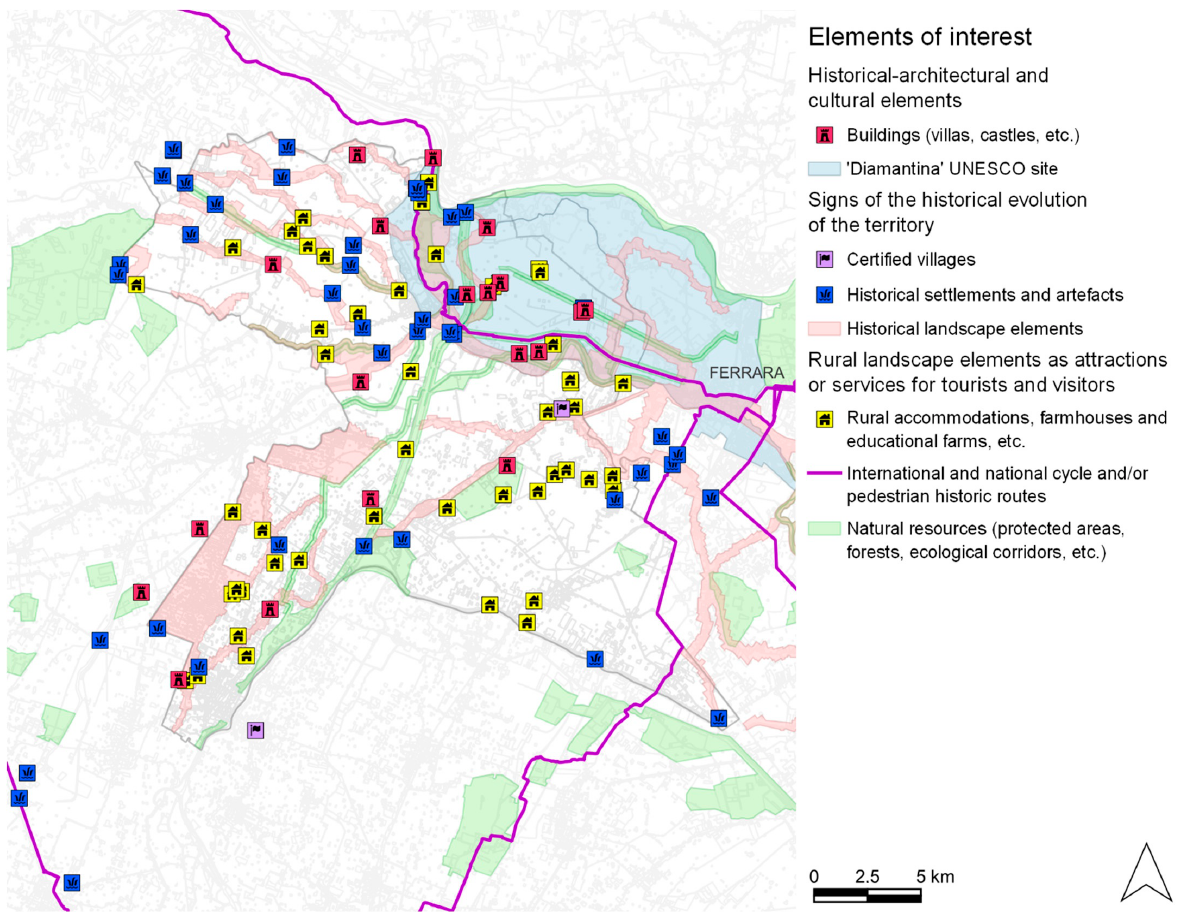
Figure 4. Elements of interest mapped in the study area.